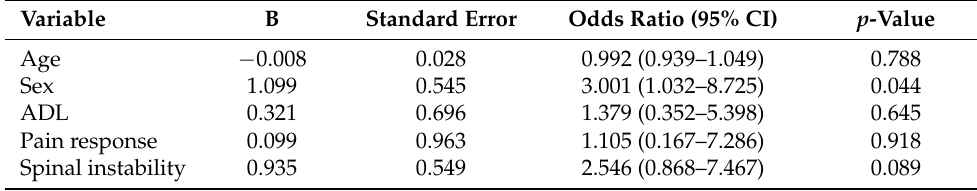
Table 6. Factors affecting emotional